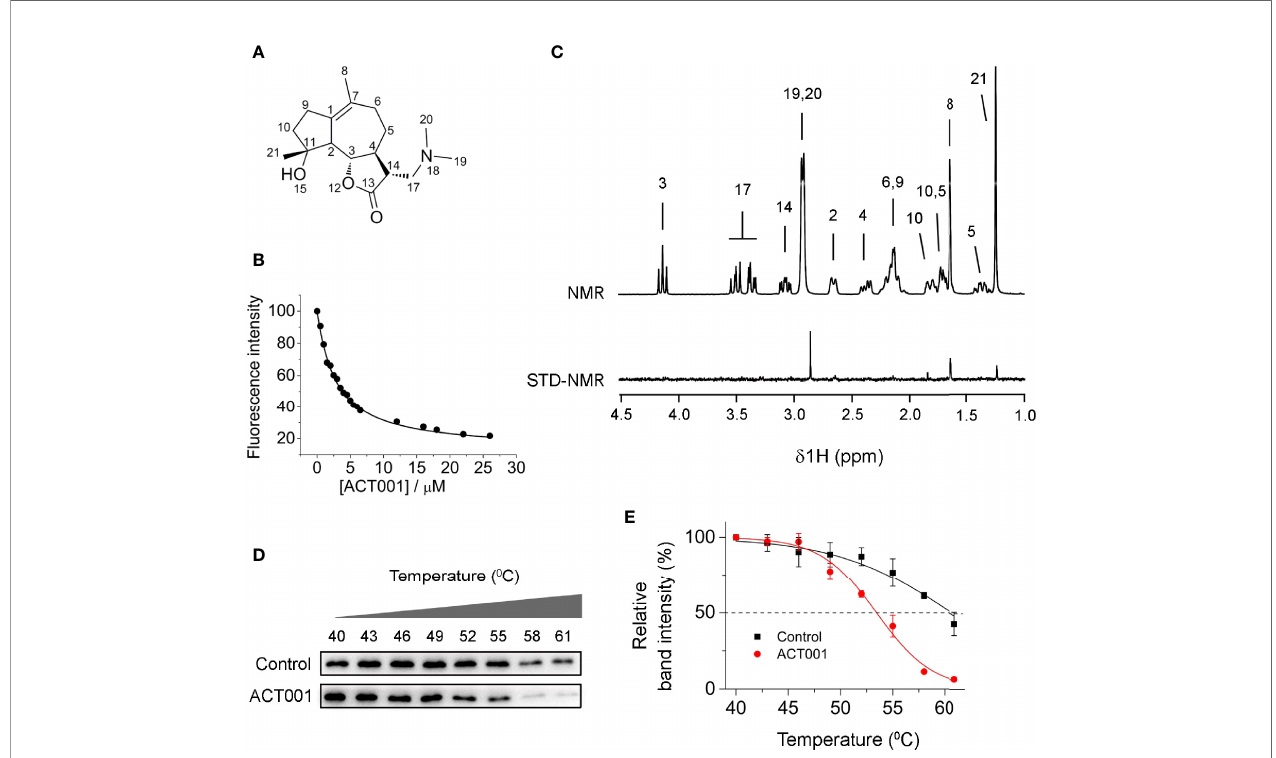
FIGURE 1 | ACT001 binds to MD2. (A) The chemical structure of ACT001. (B) Titration curve of MD2 intrinsic fl uorescence with the increasing ACT001. 280 nm was chosen as the excitation and emission at 337 nm (peak position) was plotted against the titrated ACT001 concentration. A value of K d = 2.8 ± 0.3 m M was derived by nonlinear least-square fi t a one-site-binding model for the MD2-ACT001 interaction. (C) The upper panel corresponds to the NMR assignments of ACT001; the lower panel is the saturation transfer difference spectrum recorded for 400 m M ACT001 in the presence of MD2 (4 m M). (D) Cellular thermal shift assay of MD2 with ACT001. (E) Quanti fi cation of MD2 shown in panel (D) was made using immunoblotting. Three independent cell culture preparations were performed. All data are given as the mean ±